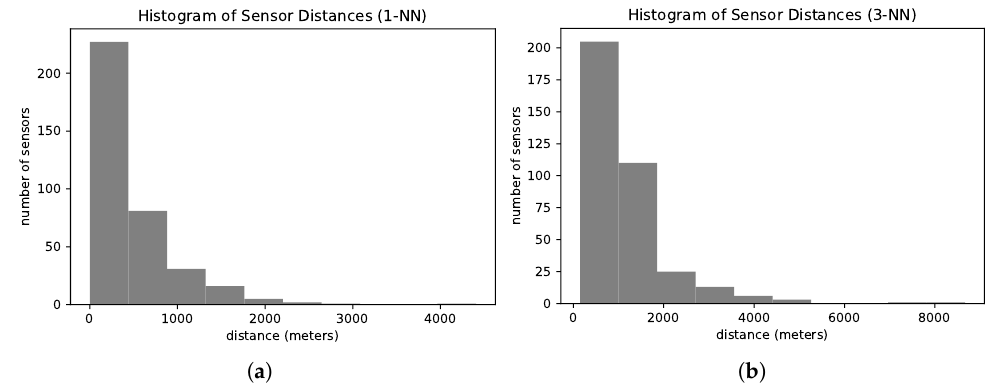
Figure 2. Histograms of road distances to nearest sensors on the road network. ( a ) Distances to the 1st nearest sensor. ( b ) Distances to the 3rd nearest